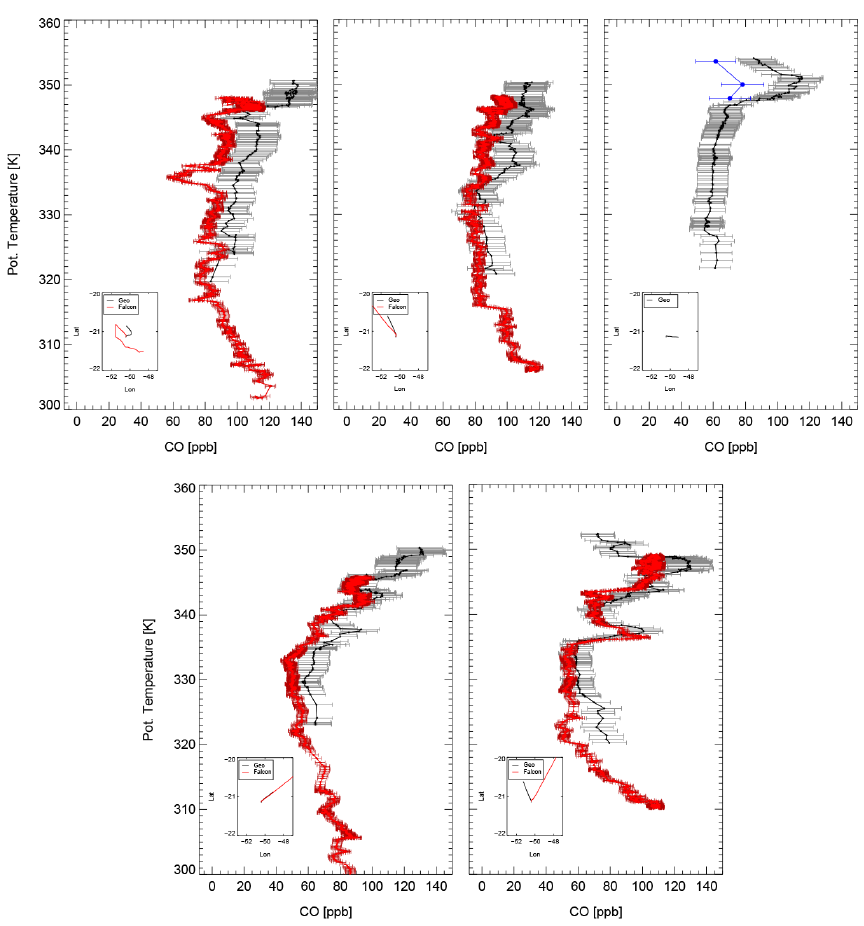
Figure A2. Comparison of CO measurements during ascent by the COLD instrument aboard the Geophysica (black) and CO measurements aboard the Falcon (red) (see Table A1 for the exact time period, which is compared). If available, data from HAGAR aboard the Geophysica are shown in blue. Shown are data for 4 February 2005 (top left), 5 February 2005 (top middle), 12 February 2005 (top right), 15 Febru- ary 2005 (bottom left), and 18 February 2005 (bottom right). Total measurement uncertainty (determined as the square root of the sum of squares of the accuracy and precision of the measurements) is shown as uncertainty range for COLD and HAGAR.